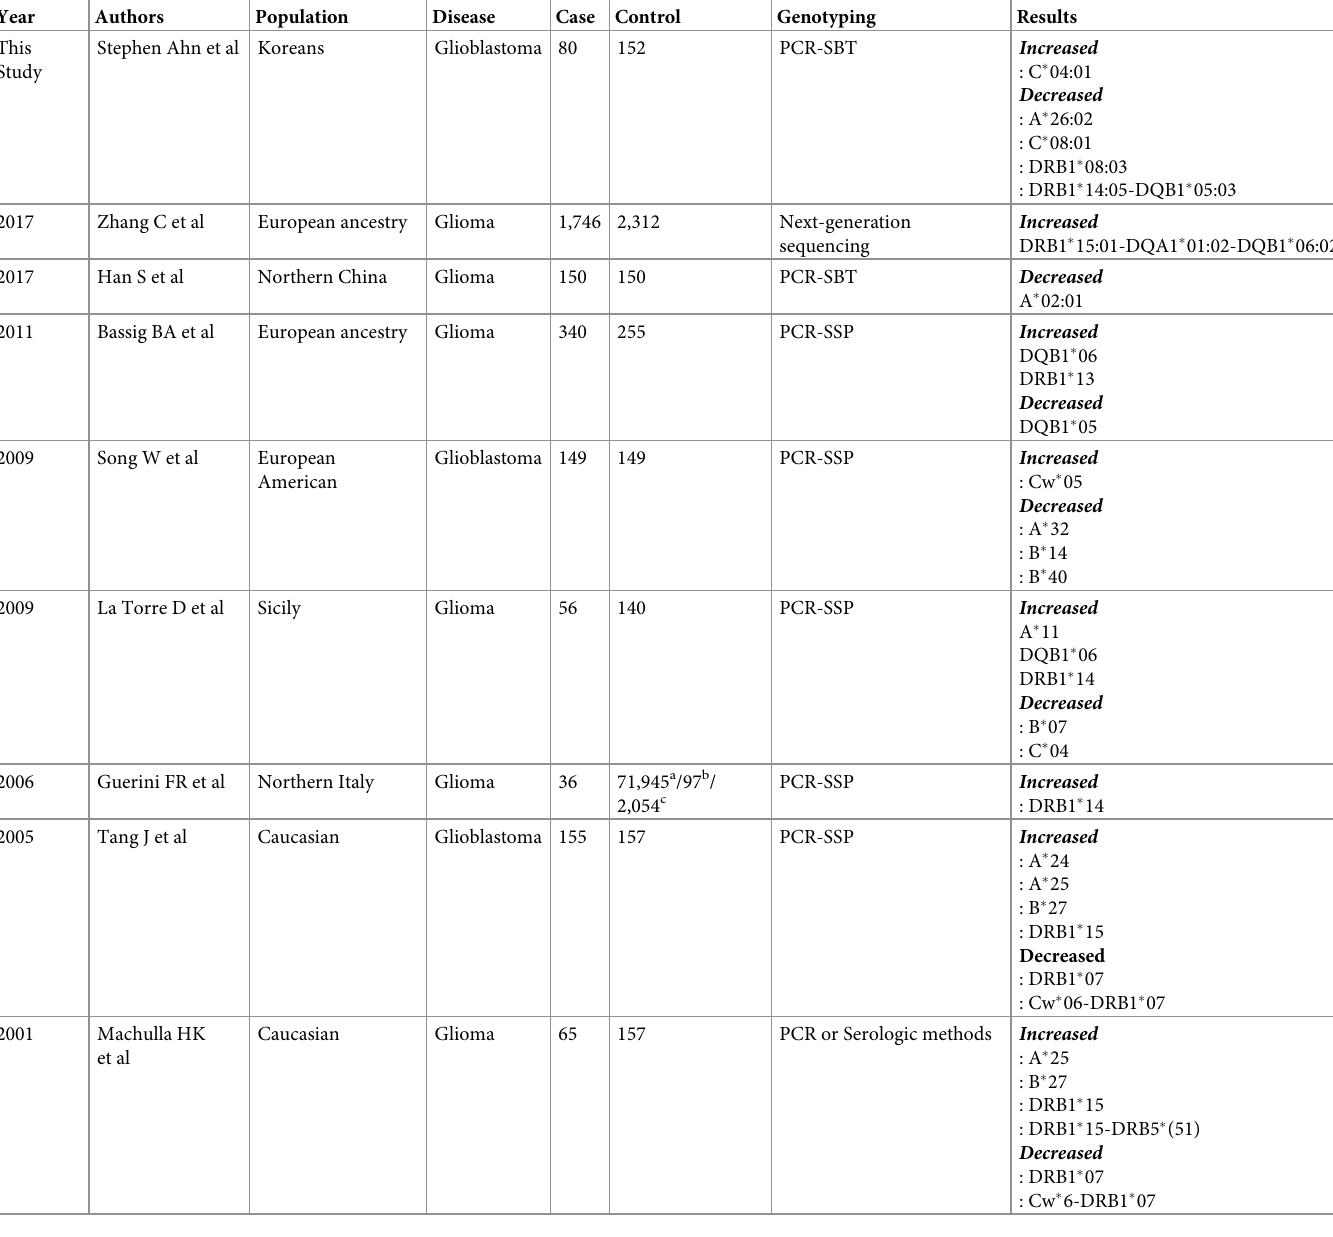
Table 5. Summary of studies evaluating associations between genetic variations of HLA and glioma